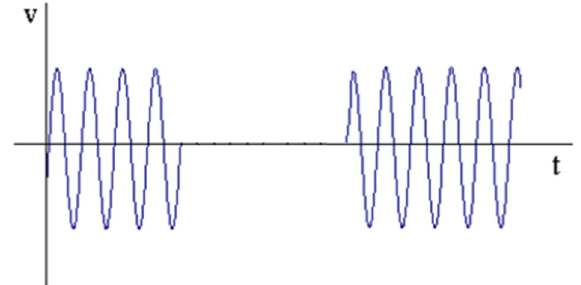
Fig. 3 Voltage waveform during